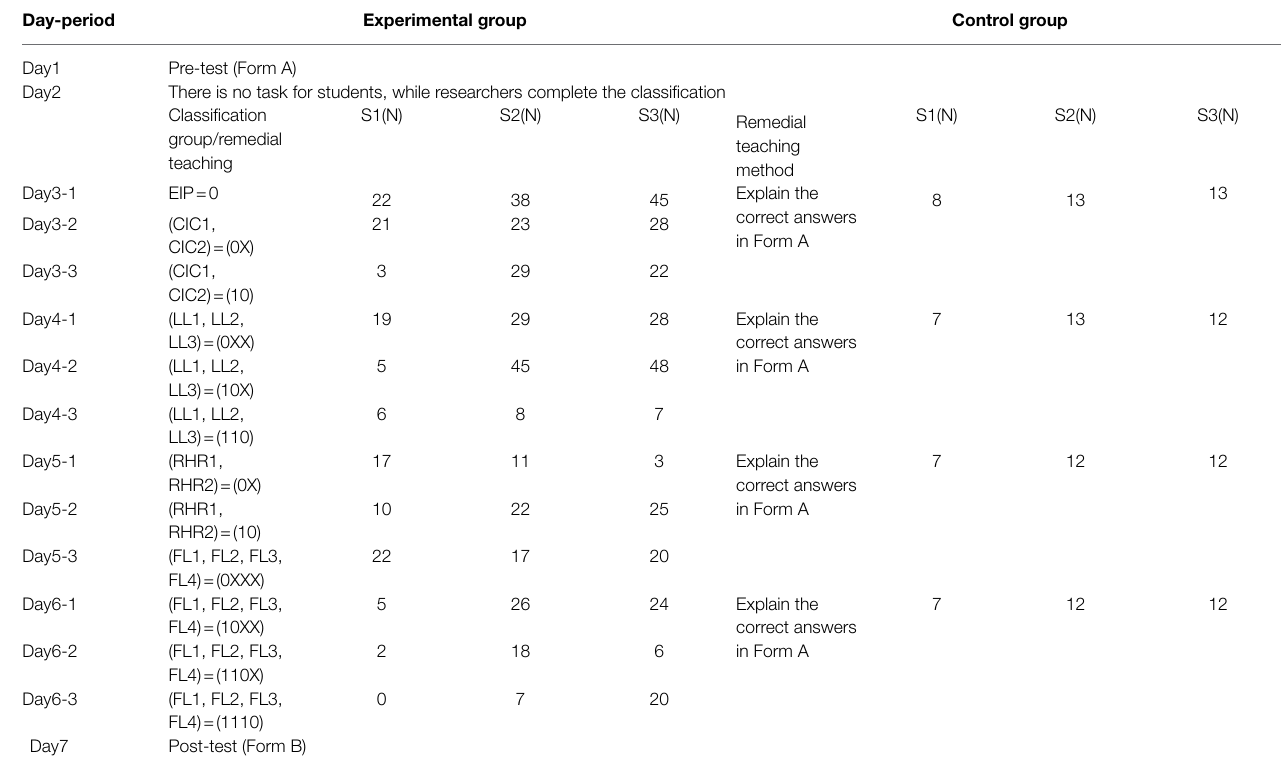
TABLE 3 | The process of the multi-level remedial teaching